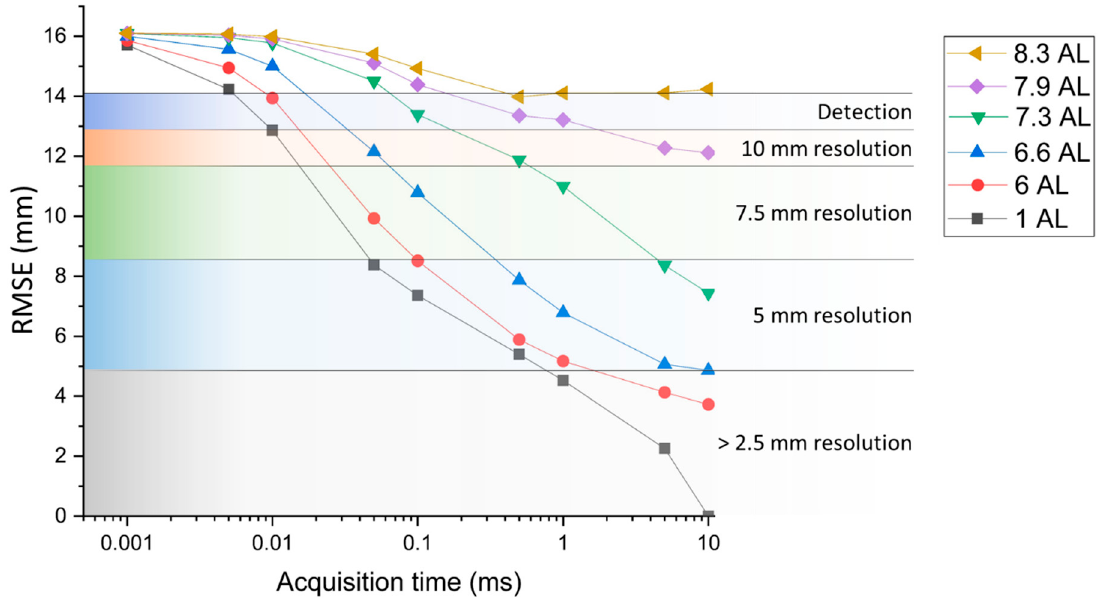
Figure 7. RMSE versus acquisition time for several underwater scattering environments. The colored regions of the graph highlight the achievable depth resolution for each RMSE range value.